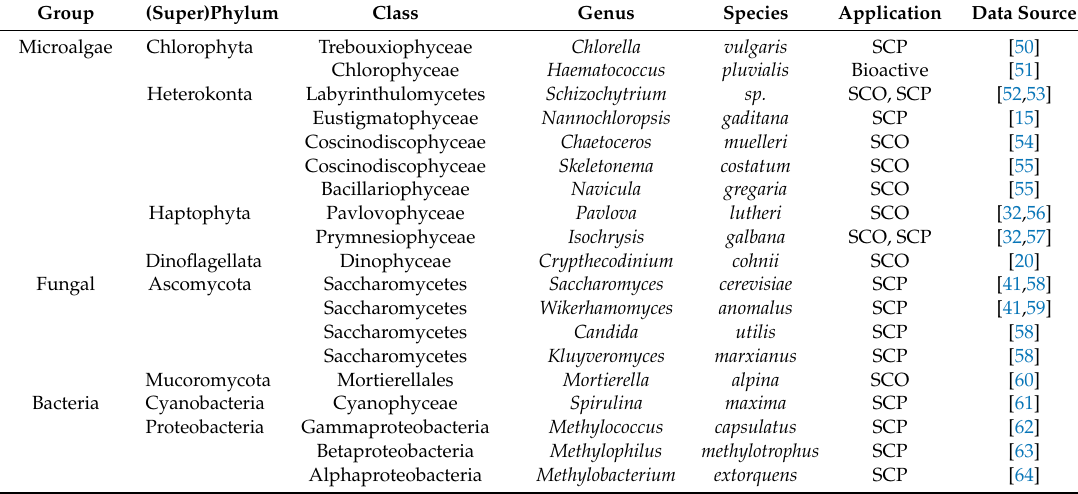
Table 1. Major groups of microalgae, yeasts and bacteria used as single-cell protein (SCP) or single-cell oil (SCO) source ingredients in aquaculture